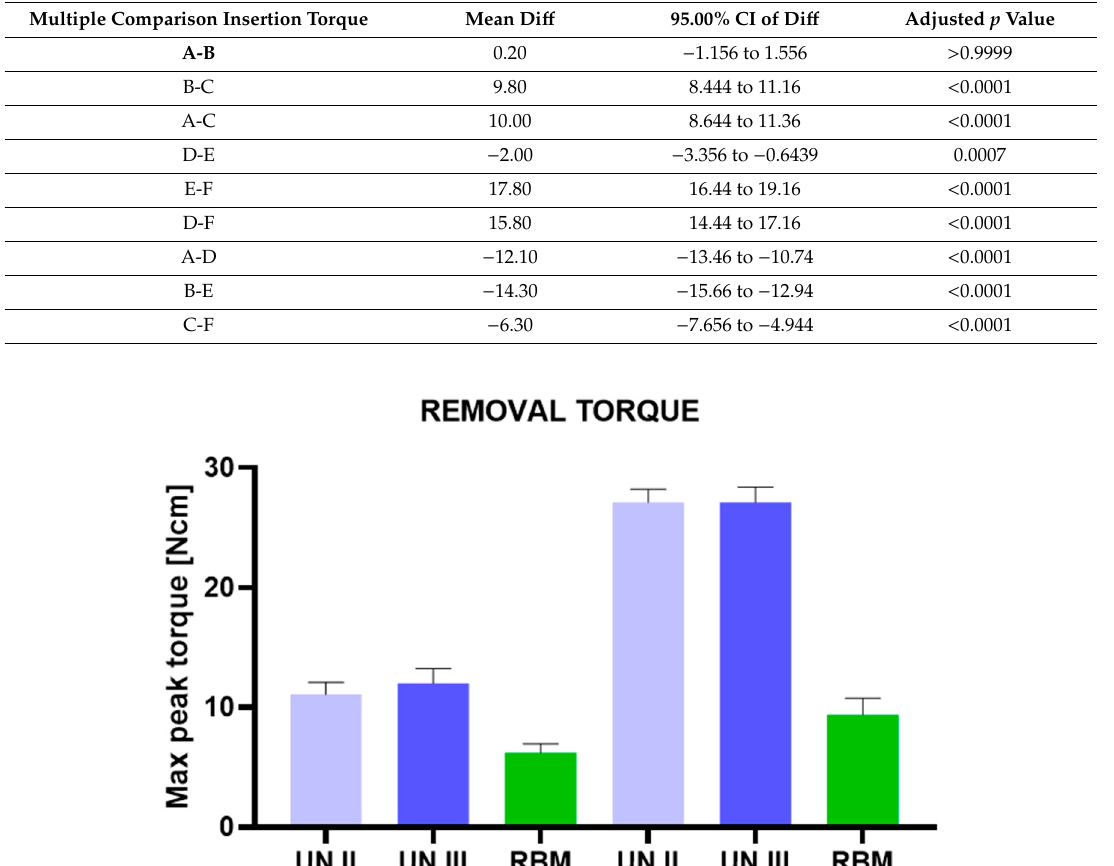
Table 2. Insertion torque ANOVA Bonferroni post hoc groups comparison.